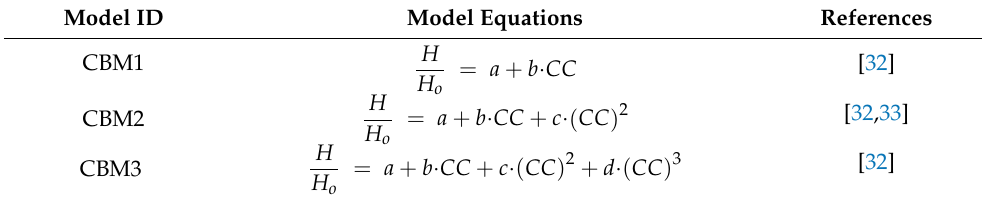
Table 5. Cloud-cover-based models used in this study.